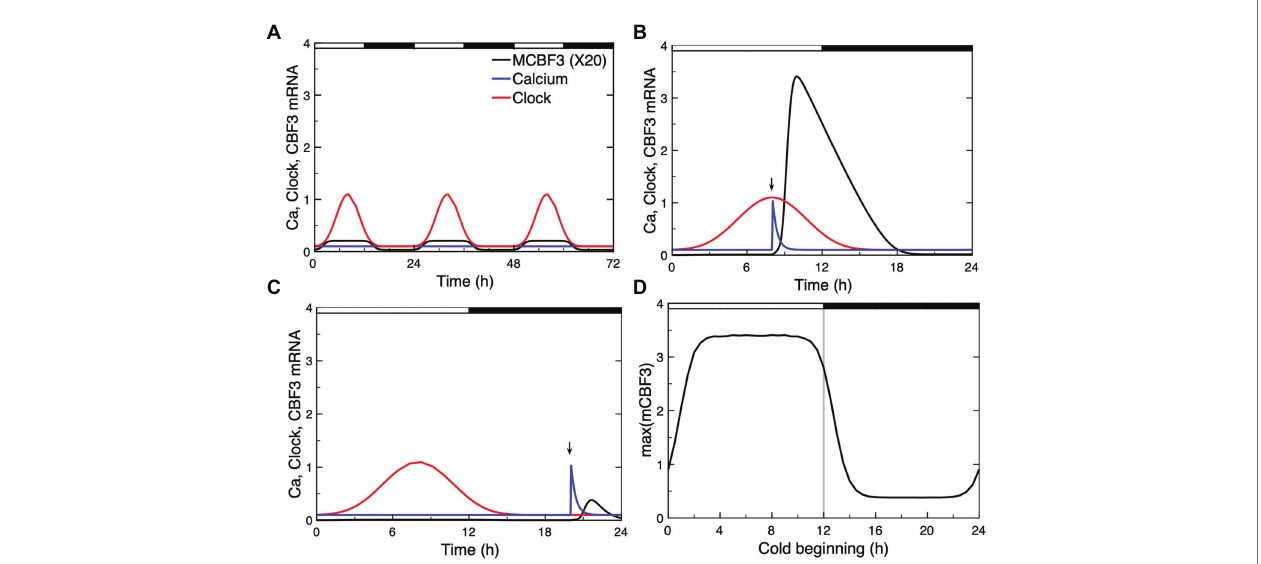
FIGURE 8 | Circadian gating of the cold response. Depending on the time of the day at which the cold stress is applied, CBF3 expression can be strongly induced or not. (A) In the absence of cold stress, the Ca 2+ level (blue curve) remains at a stable steady state, while CBF3 mRNA undergoes small amplitude oscillations (black curve) driven by the circadian clock (red curve). The 12 h light (L)-12 h dark (D) LD cycle is represented on top of the figure in such a way that the maximum in CBF3 mRNA occurs at ZT8, i.e., 4 h before the L to D transition, as observed experimentally (Dong et al., 2011). For the sake of clarity, the level of CBF3 mRNA in (A) is multiplied by 20. (B) When the cold stress, resulting in a brief Ca 2+ pulse, is applied at a phase when CBF3 driven by the circadian clock is near its maximum, the cold stress results in a large-amplitude peak in CBF3 produced by the plant cold response pathway. (C) By contrast, when the Ca 2+ pulse is applied at a phase when CBF3 is away from its maximum, the cold stress fails to elicit the activation of the plant cold response pathway. (D) Plotting the maximum of the CBF3 response as a function of the time at which the same Ca 2+ pulse is applied shows that the circadian clock defines a window of time during which a significant cold response can be achieved. The curves are obtained as described for Figure 2 , for the parameter values listed in Supplementary Table 2 . The circadian oscillation that controls CBF3 expression is generated according to eqs. (18) and (19) in Supplementary Material Section 3, with K c = 0.15 and C 0 =